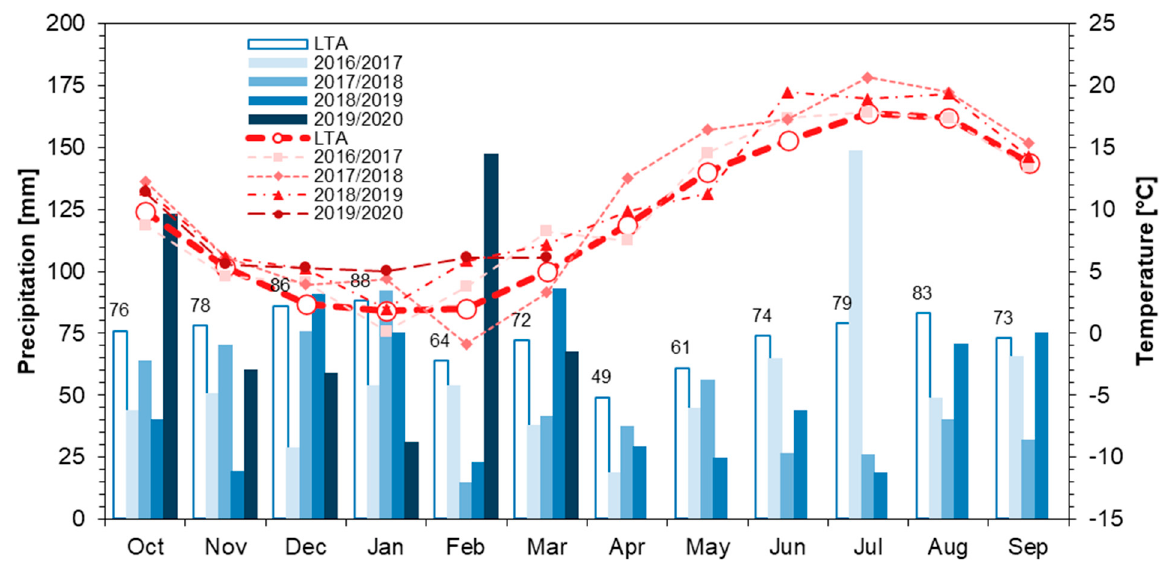
Figure 1. Monthly precipitation sums and mean air temperatures for the observed growing seasons and long-term average values (LTA) Data source: [47].